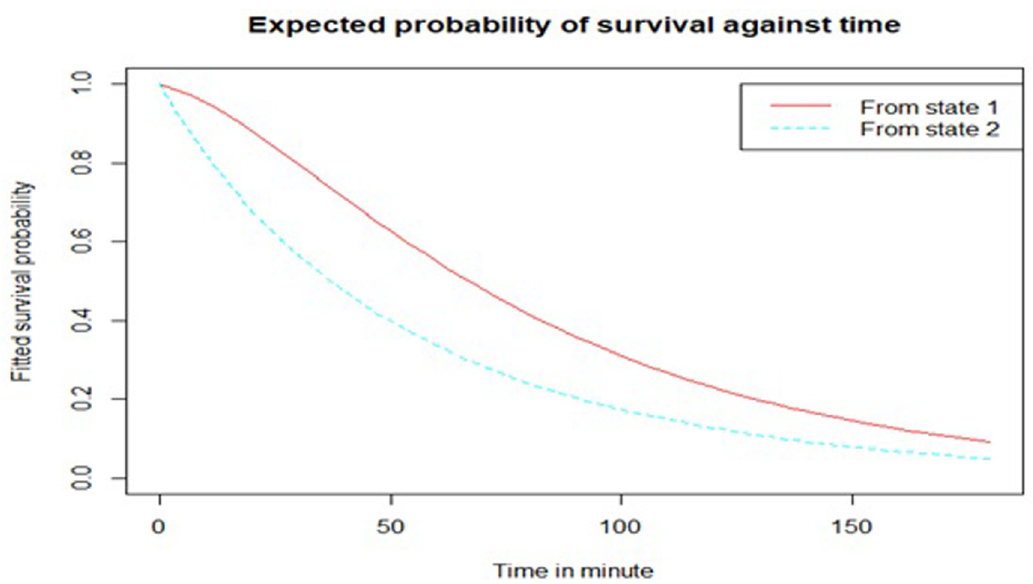
Fig 2. Time-plot of the anticipated likelihood of staying in a particular